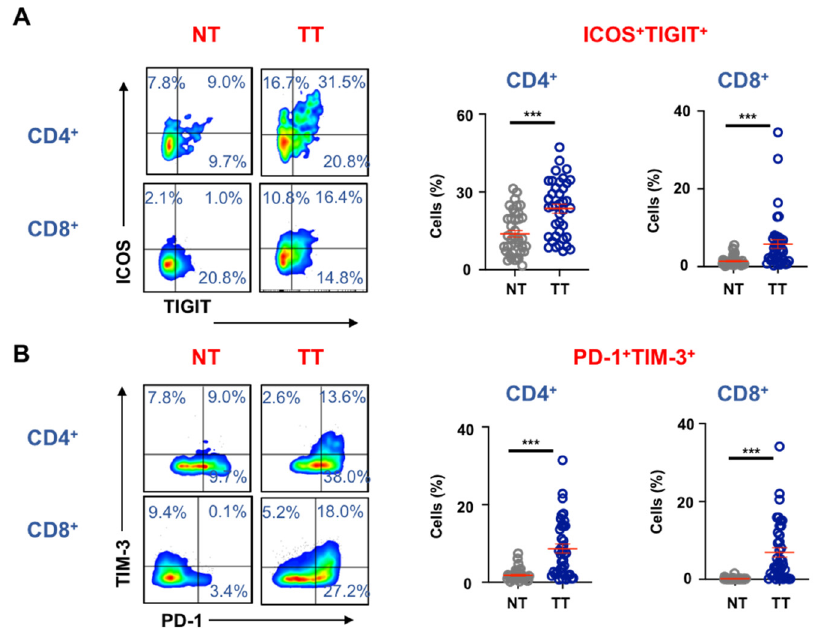
Figure 3. Immune checkpoint co-expression on different T cell subsets in the colorectal tumor microenvironment. We investigated co-expression of TIGIT/ICOS and PD-1/TIM-3 on CD4 + T cells, CD8 + T cells in TT and NT of 50 CRC patients. Representative flow cytometric plots and cumulative scatter plots show differences in levels of ICOS − /+ TIGIT − /+ ( A ) and PD-1 − /+ TIM-3 − /+ ( B ) on CD4 + and CD8 + T cells in NT and TT. The p values are represented as follows; *** p < 0.001.